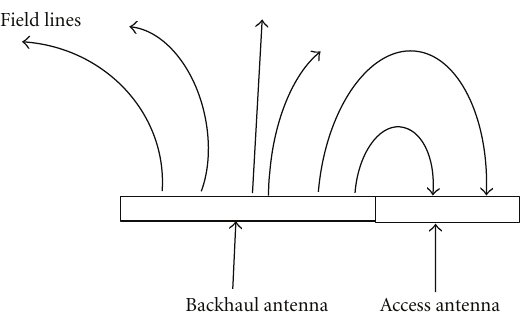
Figure 14: Field lines that cause coupling e ff ect.